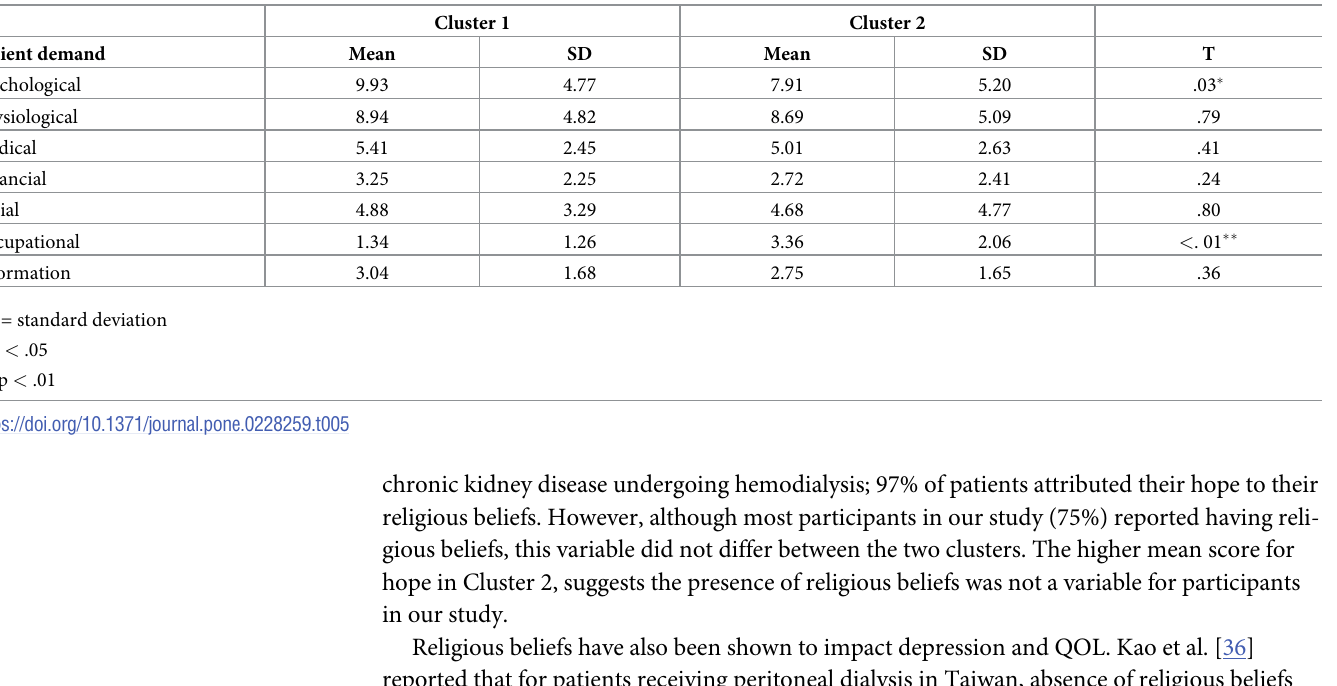
Table 5. Differences in mean scores between patient demands for Cluster 1 (n = 49) and Cluster 2 (n =